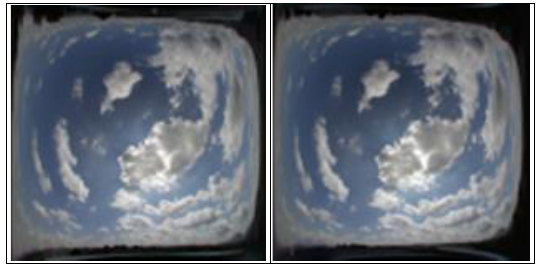
Figure 13. Rectified Images